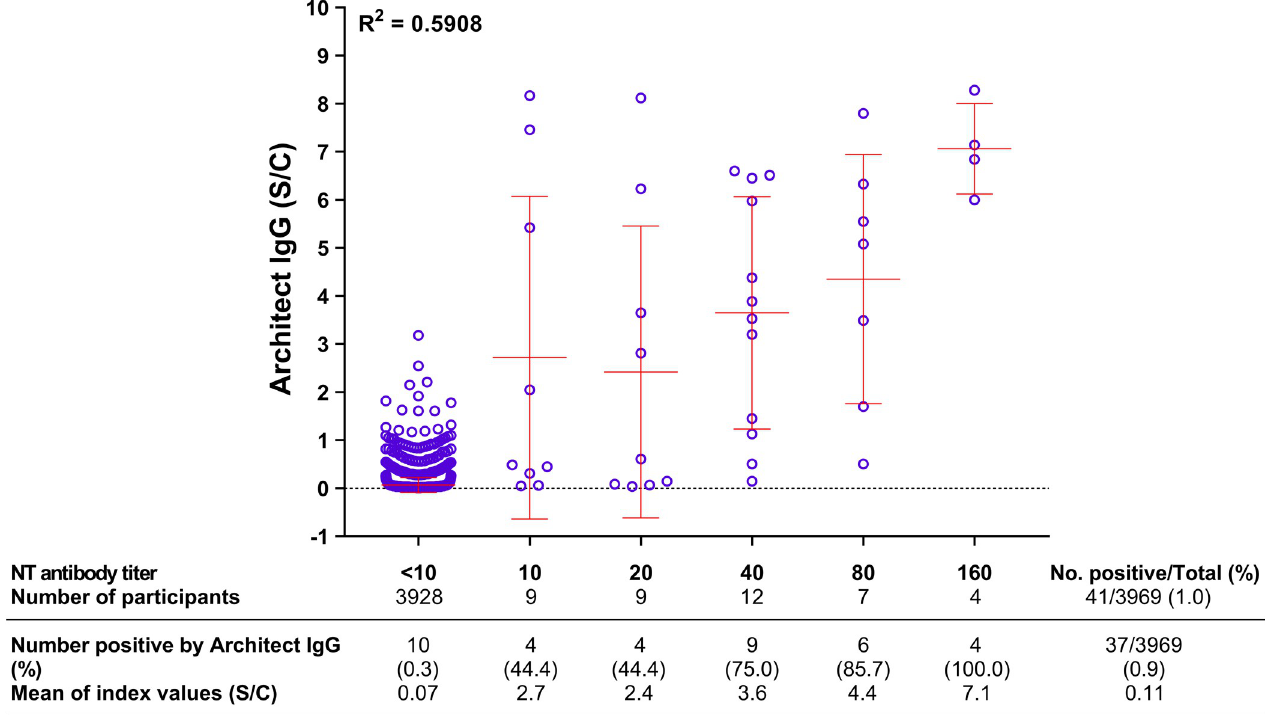
Fig 4. Correlation between NT antibody titers and Architect IgG indices in Thai people.